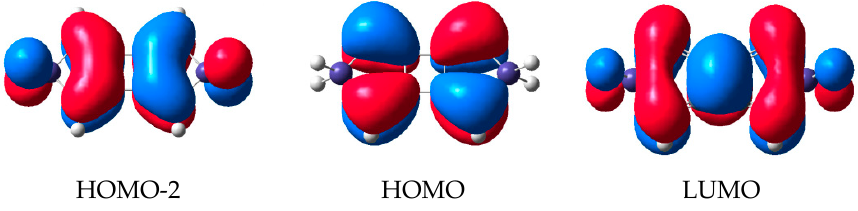
Figure 14. Frontier orbitals of unsubstituted cyclobutadisilole (R = H).